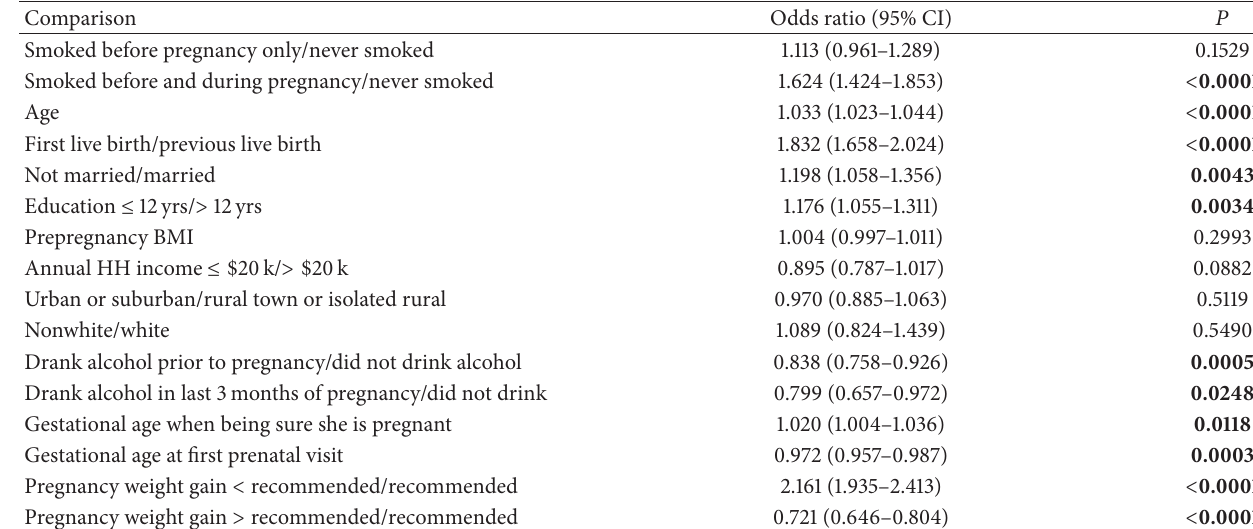
Table 3: Maternal predictors of low ( < 2500gms) versus normal birth